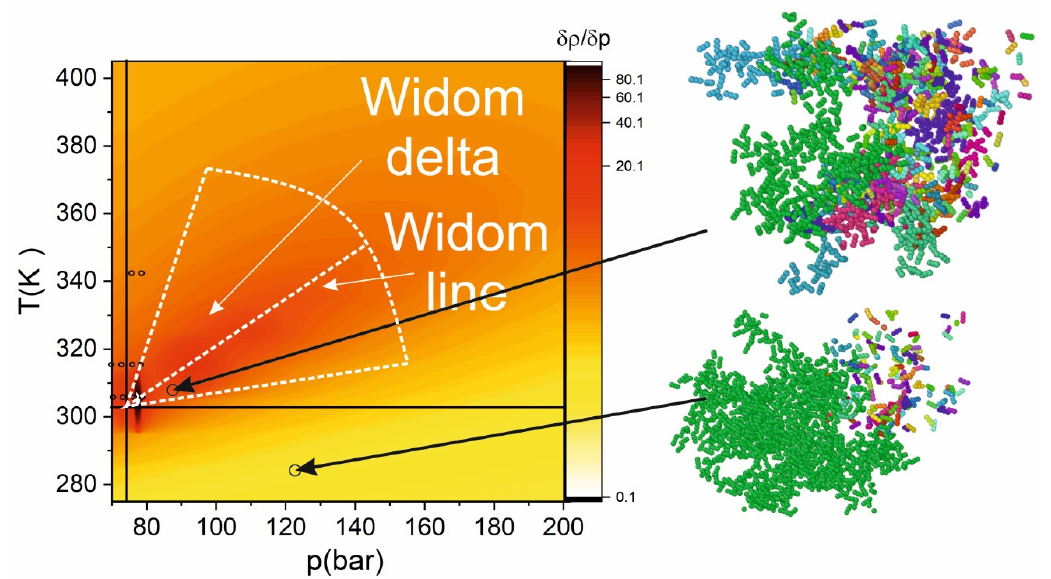
Figure 1. 3D p-T heat map of density derivative in the log scale. The outer dashed lines indicate the approximate boundaries of the Widom delta. The central dashed line shows location of Widom line. Black circles indicate the experimental points from Table 1. The insets on the right side demonstrate the molecular structure of scCO 2 . The di ff erent colors indicate the belonging to one of the clusters. The green color shows the “supercluster”. Table 1. Parameters of the cluster in the jets after passing the nozzle. The density values are from [5]. Conditions in the Supercritical Cell